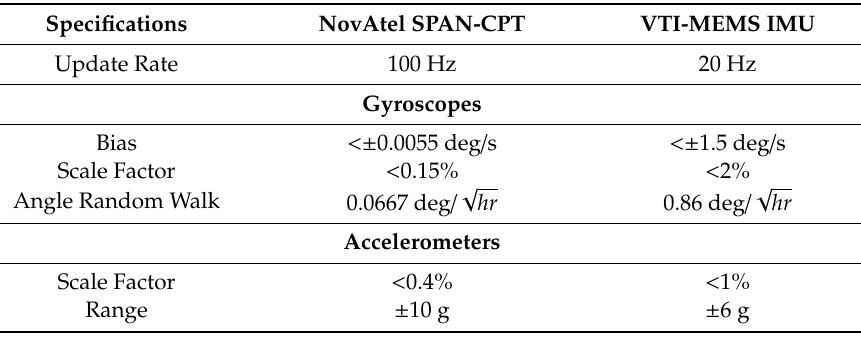
Figure 13. Sensor Setup on the Testbed. Table 1. Comparison of MEMS grade and Tactical IMU.